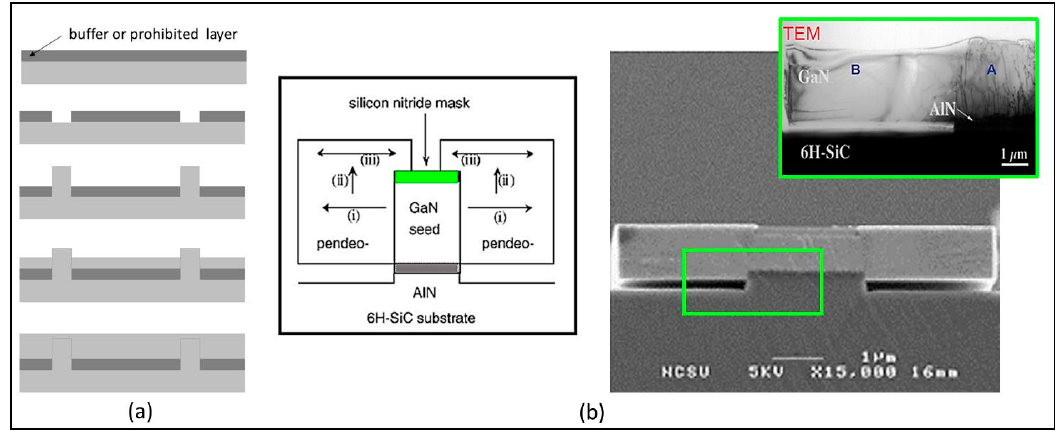
Figure 7. ( a ) Different stages of an Epitaxial Lateral Overgrowth (ELO) growth—the front of crystallization may change or not its direction; ( b ) PENDEO epitaxy: the presence of a buffer layer is not necessary; in both cases blocking the vertical growth on the ridges may be purposely done by the deposition of a layer that prohibits the growth [31]. (Reproduced from [31] with the permission of J. Cryst. Growth ).